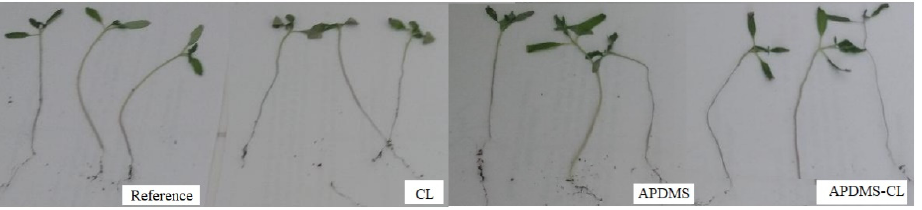
Figure 10 . Dry tomato plants three days after harvest .